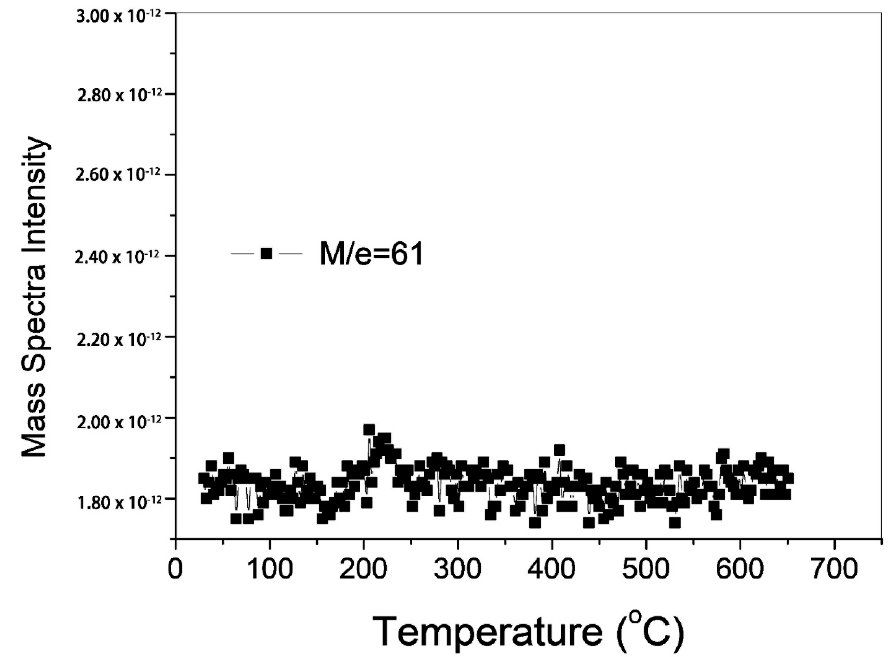
Figure 1. The glycerol desorption in TPSR of SAPO-11 (M/e = 61).